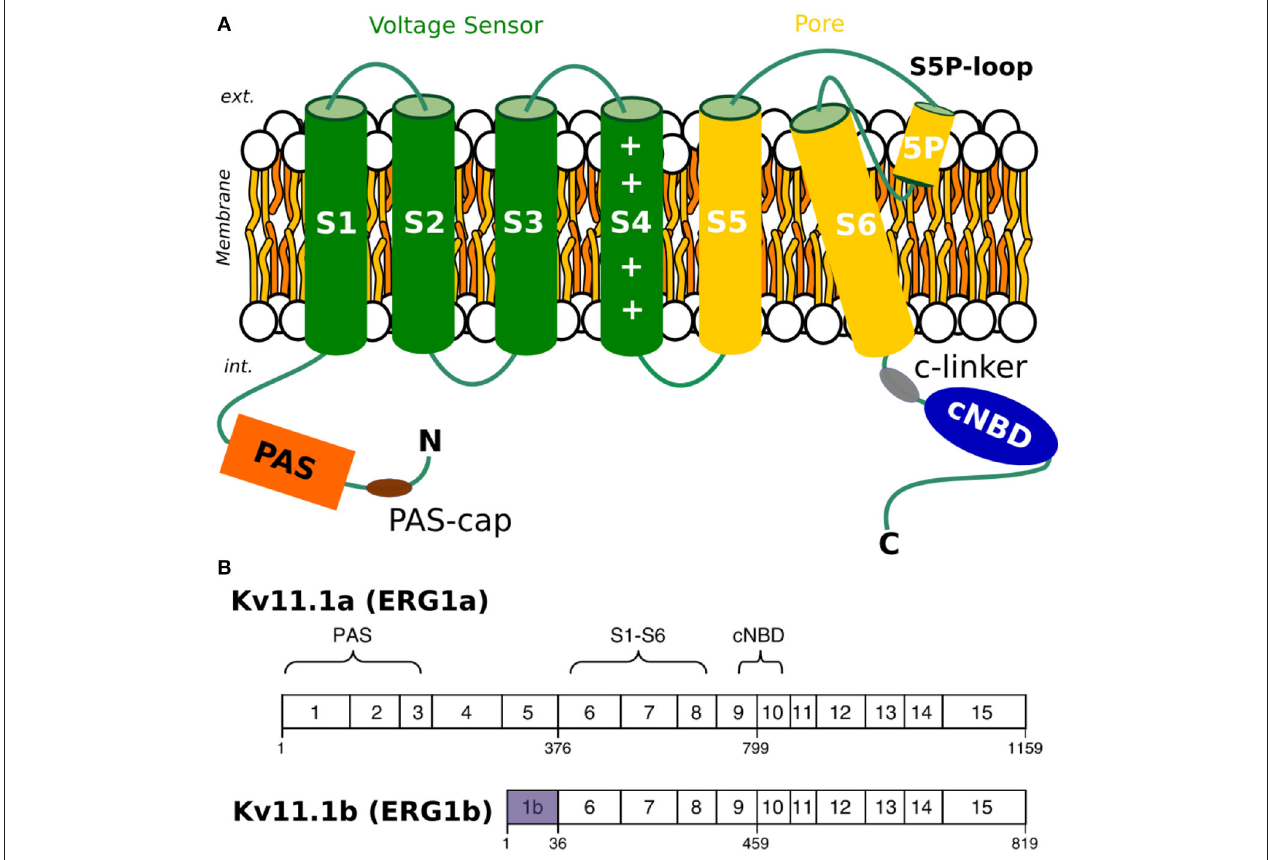
FIGURE 1 | (A) Topology of Kv11.1 or hERG channel. (B) Comparison of a-isoform and b-isoform. Exons of each of the two splice variants, with a-isoform on the top and b-isoform on the